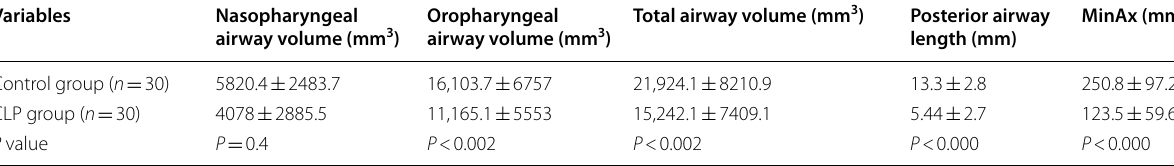
Table 2 Airway volumes and cross-sectional area in CLP patients and non-cleft controls